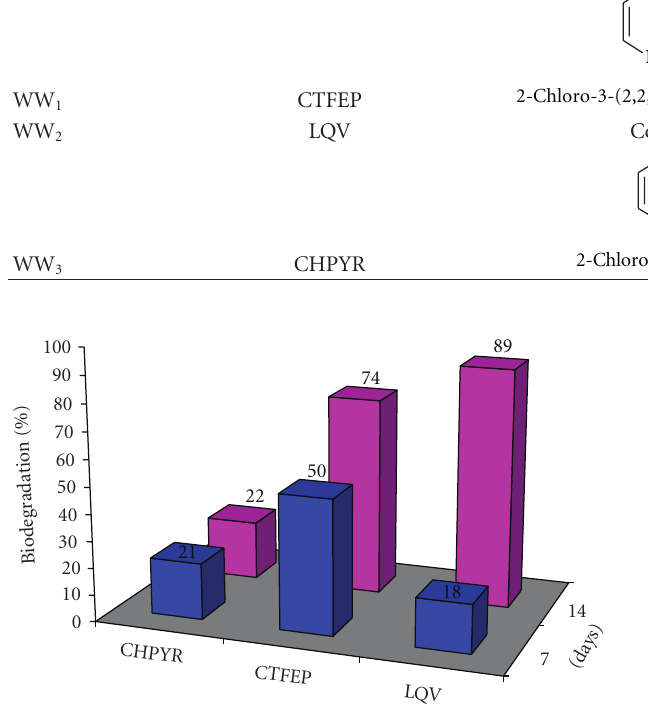
Figure 3: Percentage of biodegradation respectively 07 ( ) and 14 days (